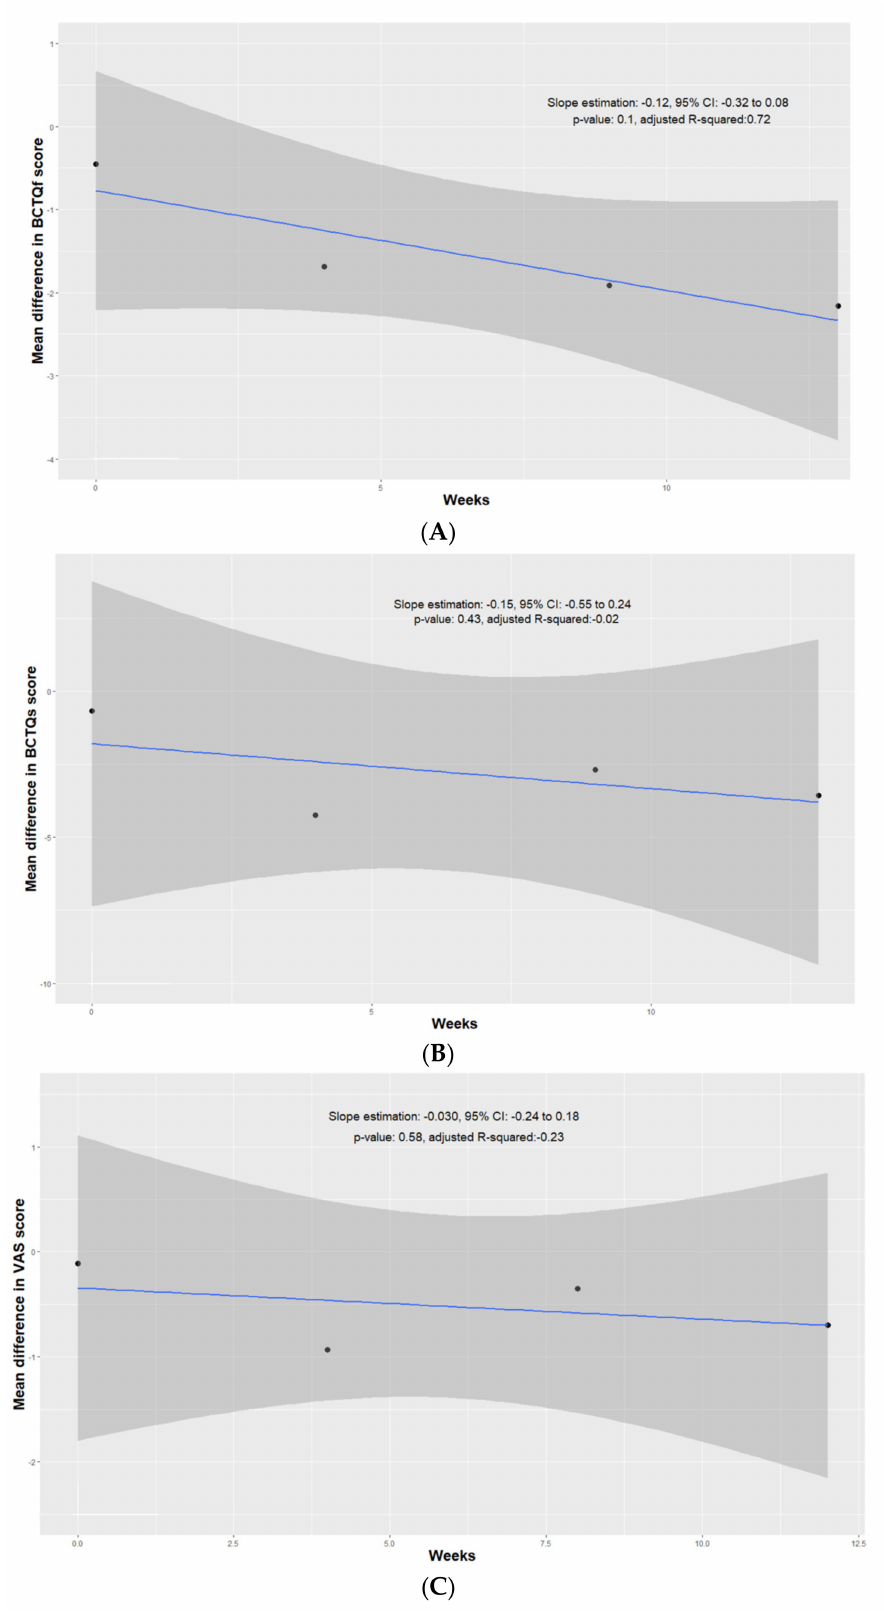
Figure 3. Linear regression model of ( A ) pooled BCTQf score, ( B ) pooled BCTQs score, and ( C ) pooled VAS score evaluating ESWT/night wrist splint and night wrist splint alone groups at baseline, 4 weeks, 9 weeks, and 13 weeks after